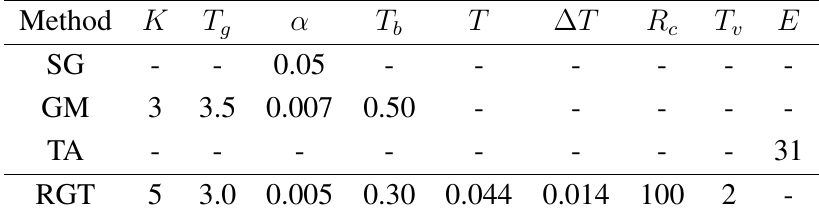
Table 1. Parameters for the experiment using Wallflower dataset.